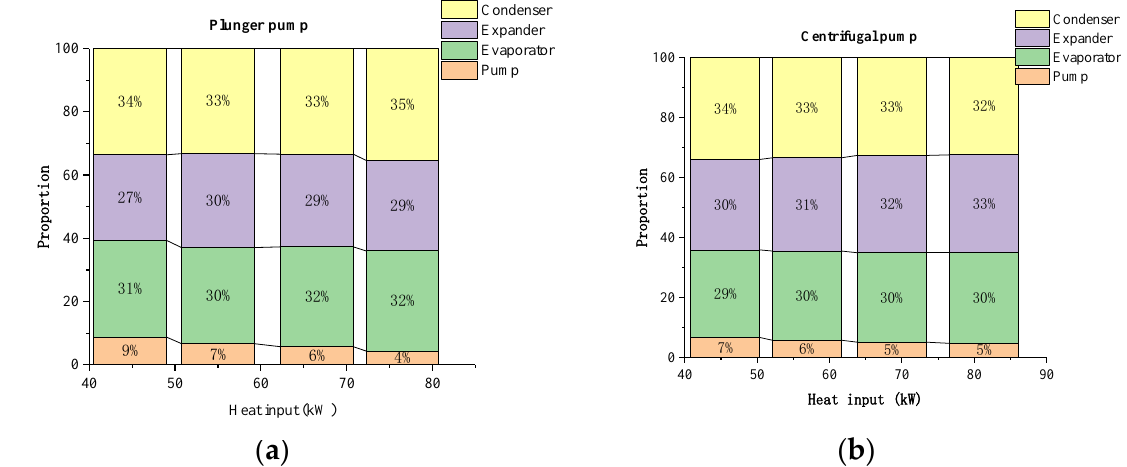
Figure 16. The proportion of exergy destruction for each component with heat input using the plunger pump and centrifugal pump: ( a ) the proportion of exergy destruction using the plunger pump; ( b ) the proportion of exergy destruction using the centrifugal pump.